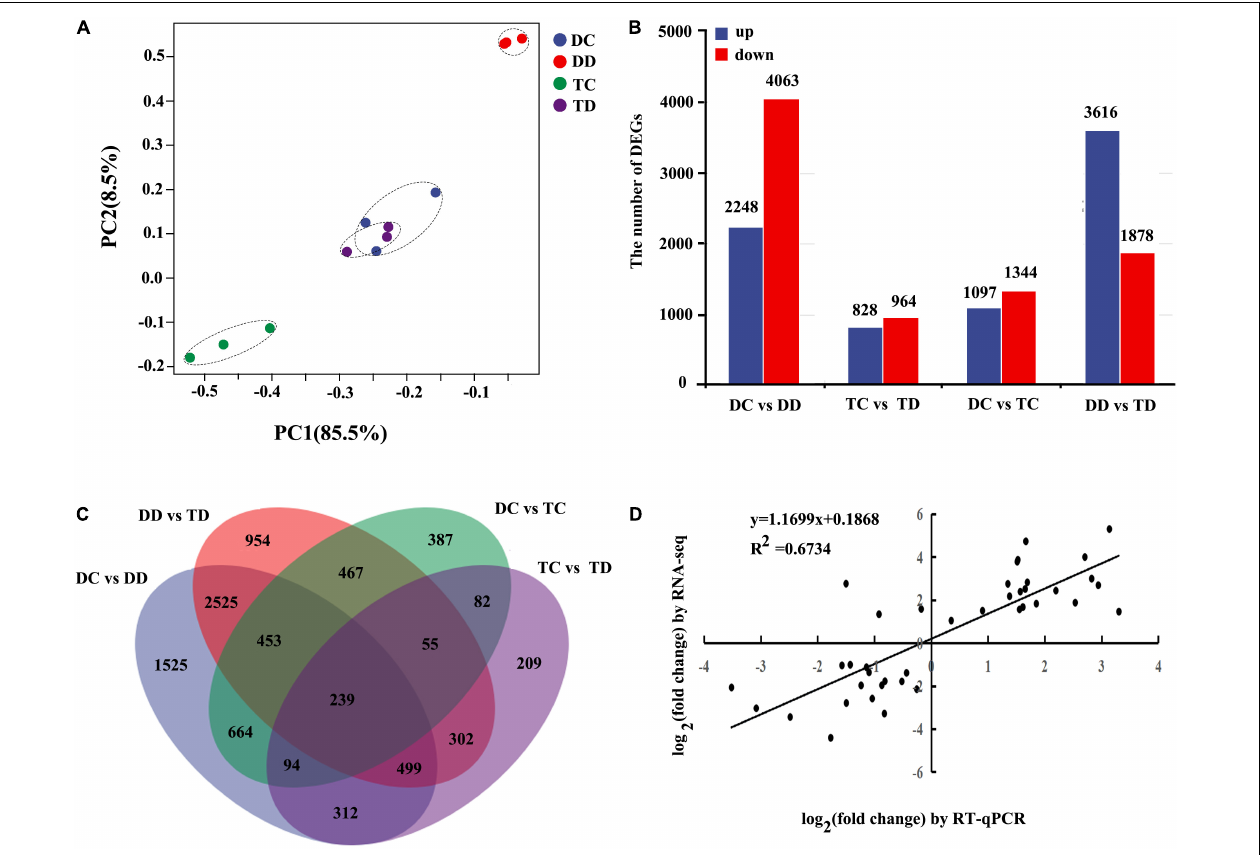
FIGURE 3 | Differentially expressed genes in diploids and tetraploids Citrus wilsonii with or without drought treatment were analyzed by RNA-seq and RT-qPCR. The similarity of the expression of genes was compared between sample groups using PCA. The top 500 genes with the highest contribution were chosen for PCA analysis (A) ; comparison analysis of DEGs in the DD vs TD, TC vs TD, DC vs TC, and DC vs DD were shown in column chart (B) ; common and specific DEGs were compared between the different pairwise comparisons using the Venn diagram (C) ; correlation of expression analysis by RNA-seq ( Y -axis) and RT-qPCR ( X -axis) (D) .